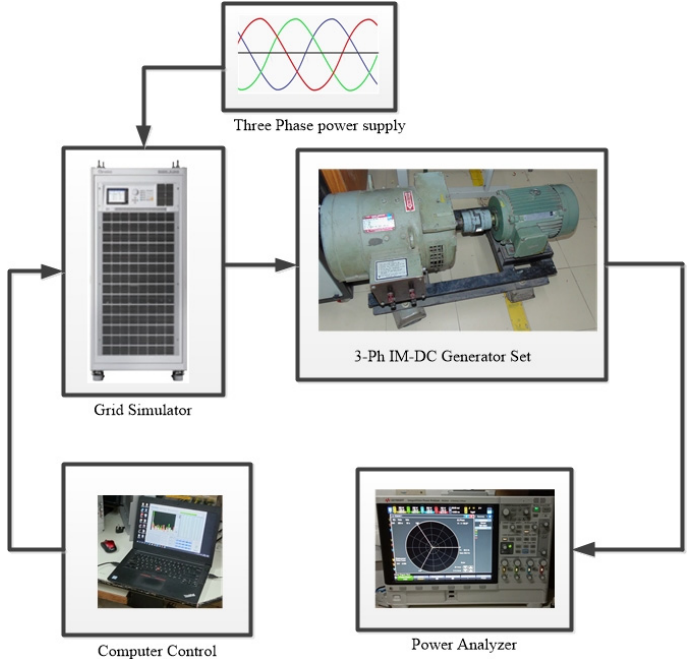
Figure 2. Voltage sag testing setup.